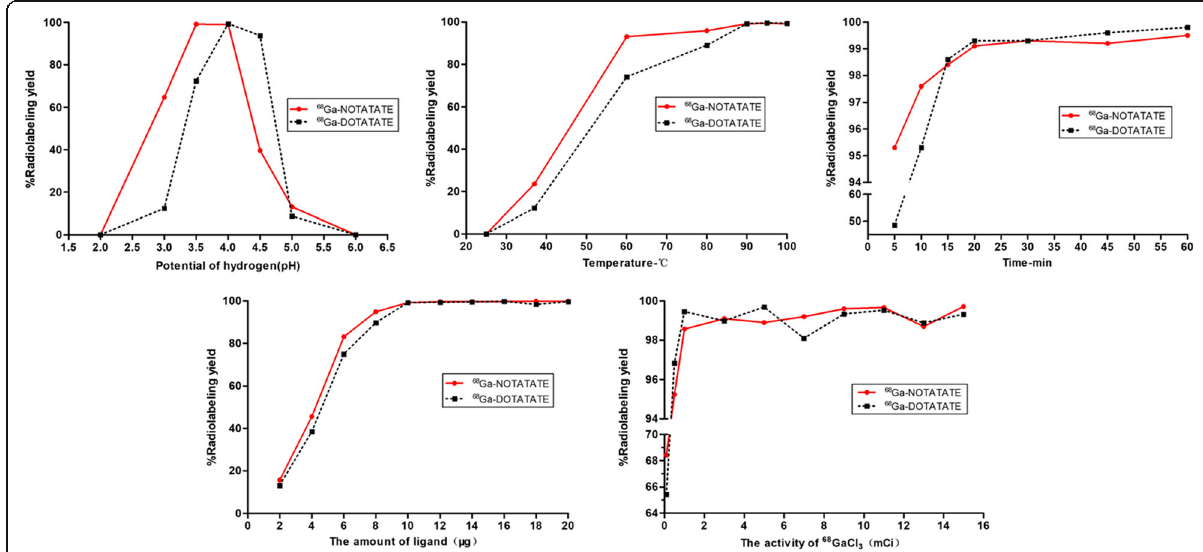
Fig. 2 The factor effects on the radiochemical purity of 68 Ga-NOTA-TATE and 68 Ga-DOTA-TATE